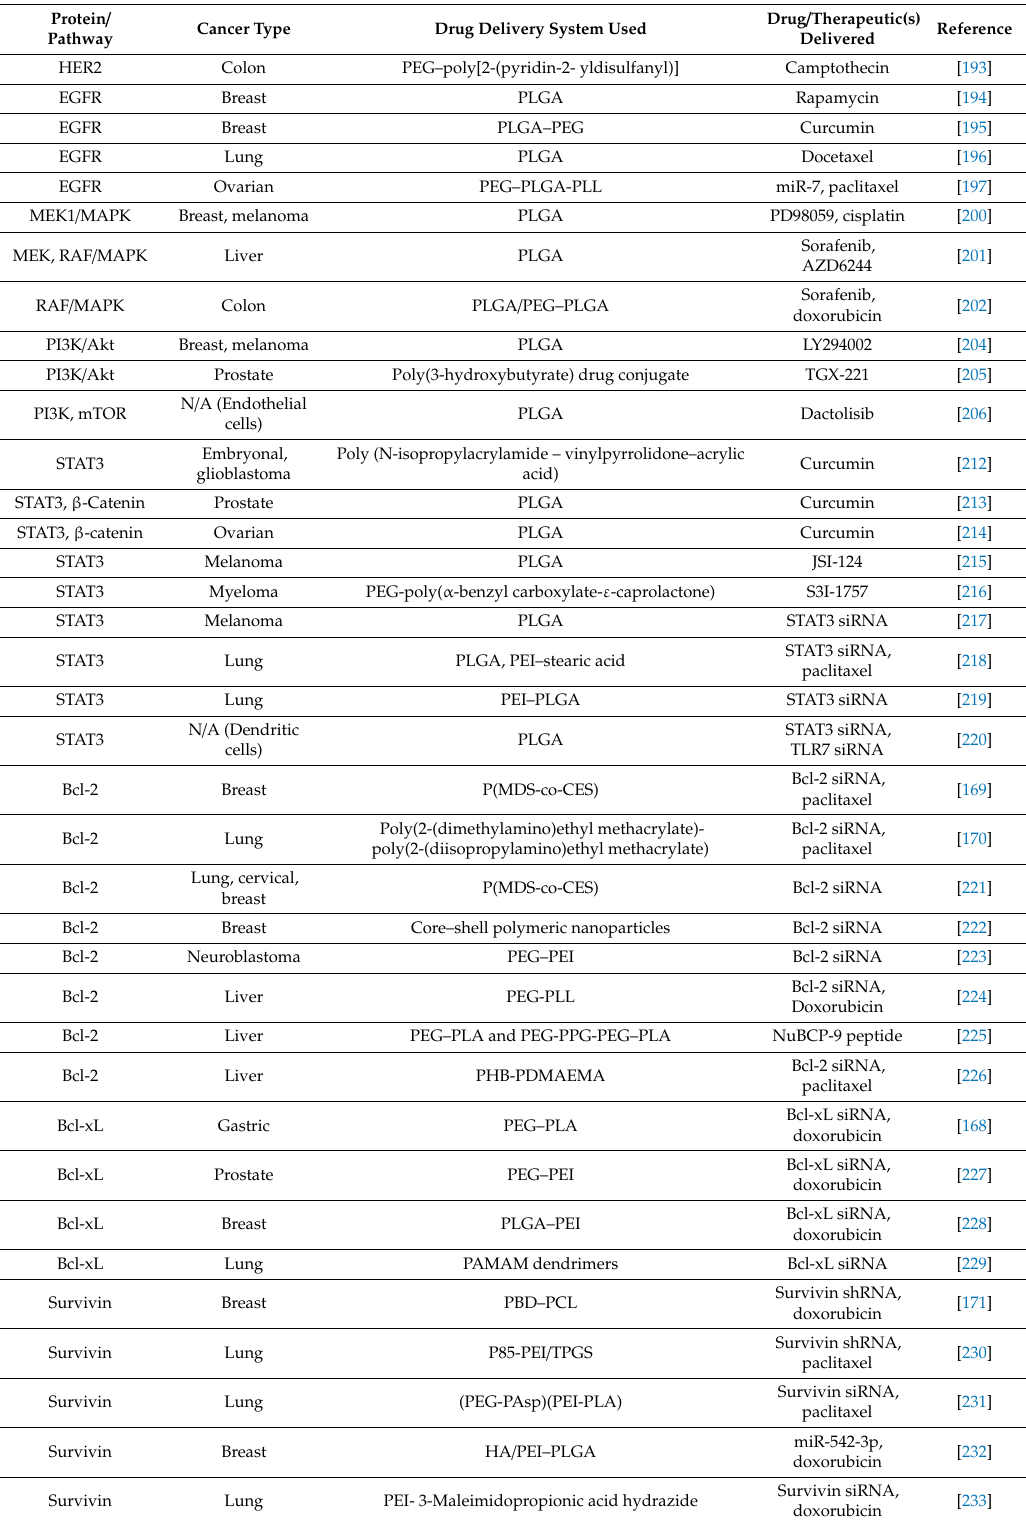
Table4. Summaryofstudiesusingpolymericnanoparticlesystemstotargetpathwaysforcancertherapy. Protein /